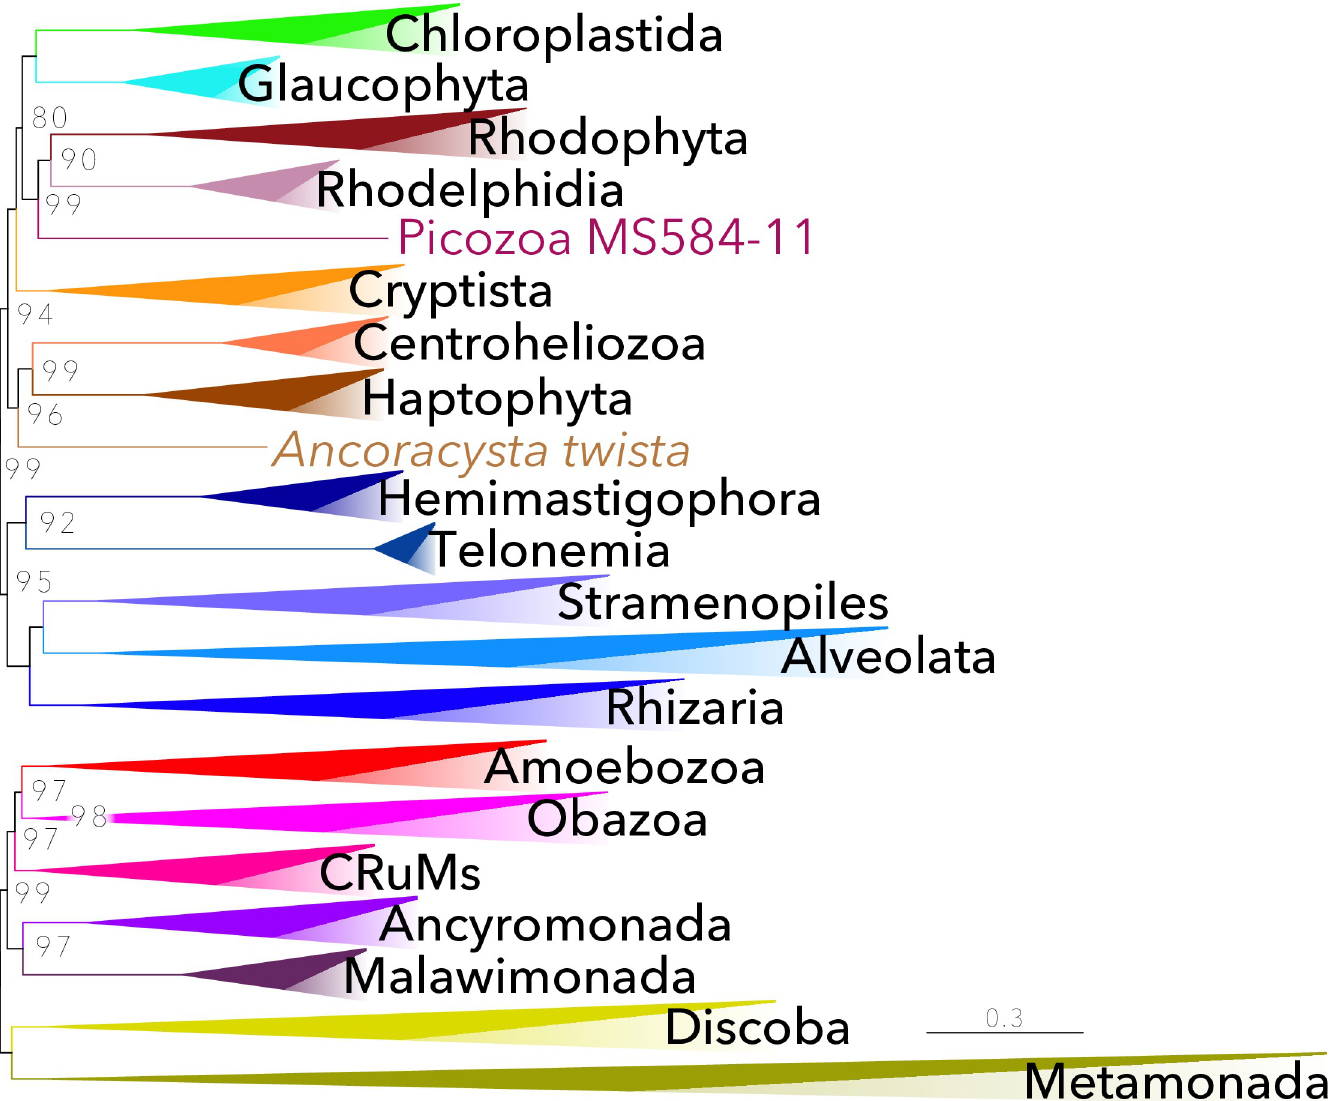
Fig 3. Phylogenetic tree for 304 eukaryotes, inferred from 240 proteins. The tree was inferred using ML (LG+G4+F+C60-PMSF model, with an LG+G4+F+C20 ML tree as a PMSF guide input tree) in IQ-TREE v1.6.7.1 [14]. Single-protein alignments were processed with the PhyloFisher utility matrix_constructor . py . See Materials and methods for details. The numbers on branches show support values from 350 ML bootstrap replicates. All nodes are fully supported (100% MLBS) unless otherwise shown. Highly supported clades of high taxonomic level have been collapsed; the full ML tree is available as Fig A in S1 Text. Taxon details are available in S1 Table. This tree was inferred from the full concatenated alignment (72,632 sites). Further detail into the methodology may be found in the Materials and methods and S1 Text. ML, maximum likelihood; MLBS, maximum likelihood bootstrap support; PMSF, posterior mean site frequency.